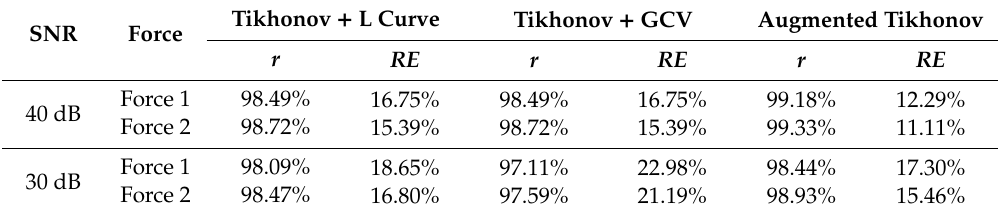
Table 3. Identification e ff ect of two impact loads.